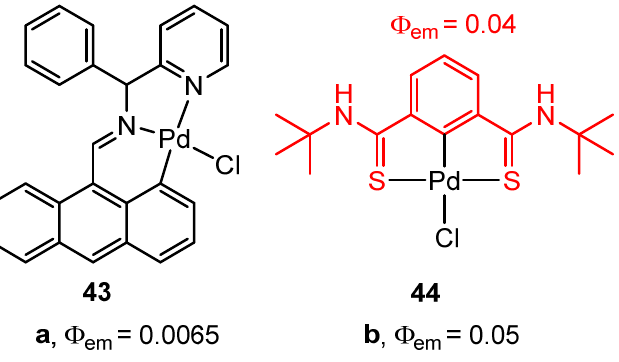
Figure 14. Pd(II) complexes containing tridentate ligands derived from ( a ) 2-(2(anthracen-9- ylmethylene)-1-phenylhydrazineyl)pyridine and ( b ) N , N ’-di-tert-butylbenzene-1,3-dicarbothioamide by C-H activation. Adapted from [76,77].